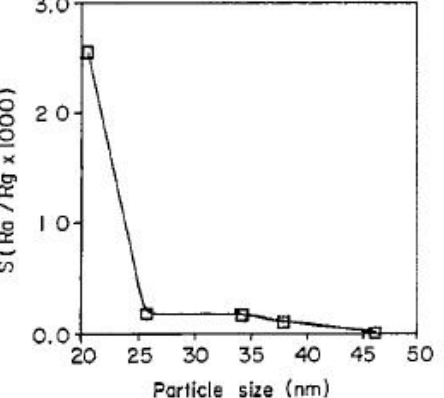
Figure 8. Variation in sensitivity with average particle size (adapted from